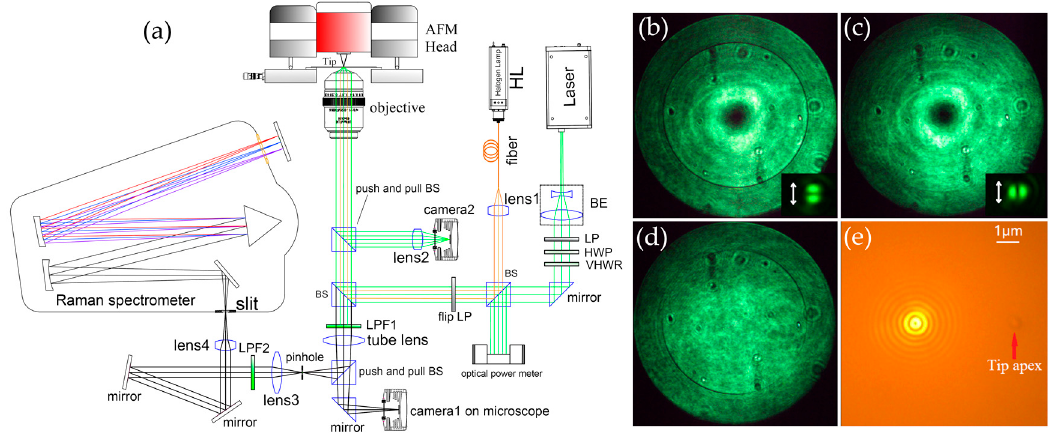
Figure 1. ( a ) Schematic of our atomic force microscope (AFM)-based tip-enhanced Raman (TERS) setup. Intensity distribution at the back focal plane of the microscope objective (camera2) after reflection when the polarized laser ( b ) radially polarized, ( c ) azimuthally polarized, and ( d ) linear polarized is focused on a glass coverslip coated with a 50 nm-thick Ag film. The dark ring corresponds to the surface plasmon excitation. The insets in ( b , c ) (camera1) show the splitting direction of the laser focal spot of the corresponding polarization after passing through an additional flip linear polarizer (LP). The direction of the transmission axis of the LP is indicated by a white arrow. ( e ) Image captured by camera1 showing the laser focal spot and TERS probe apex simultaneously. Abbreviations: BS: Beam splitter, BE: Beam expander, LP: Linear polarizer, HWP: Half-wave plate, VHWR: Vortex half-wave retarder, LPF: Long-pass filter, HL: Halogen